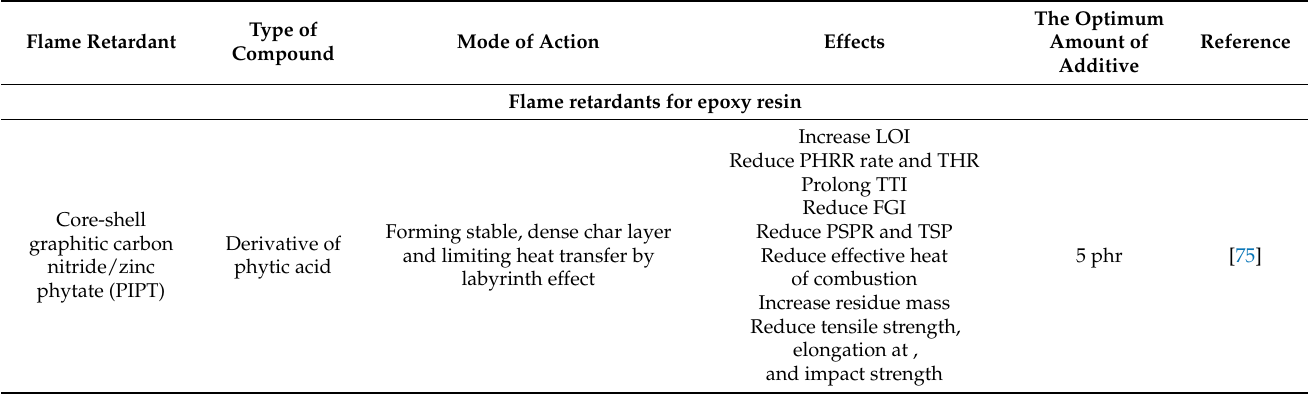
Table 3. Overview of additive flame retardants for thermosetting